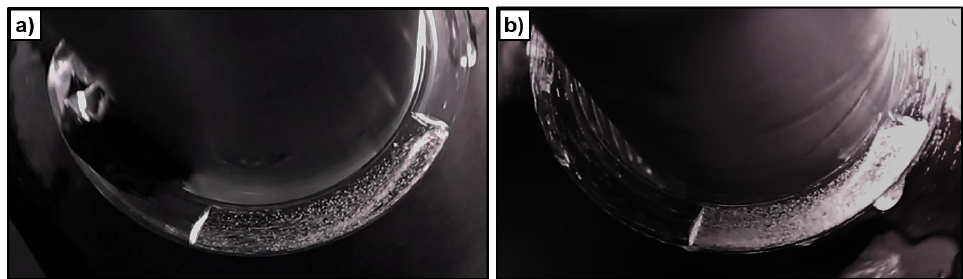
Figure 13. Experimental suspension state for d mod = 182 µ m at n ATC = 40min − 1 and (cid:101) = 0.25 for ( a ) solid content w solid = 1 g Ala · 100 g − 1 Corresponding individual figures and accompanying videos are supplied in the Supplementary Material as ( a ) Figure S27 and ( b ) Figure